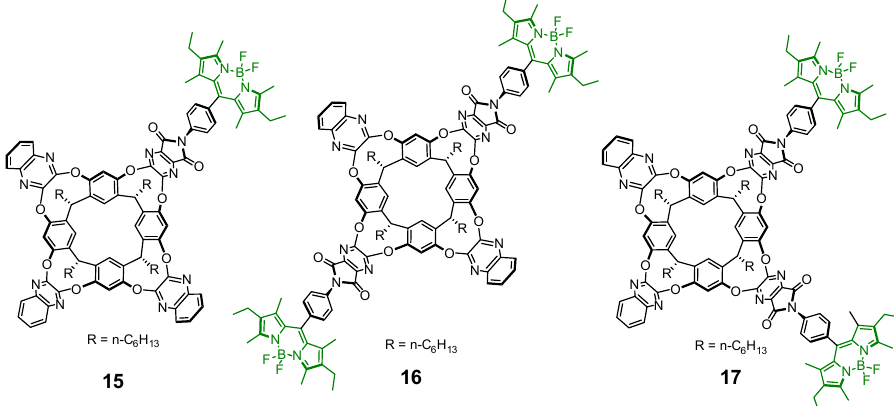
Figure 14. Chemical structures of BODIPY-decorated resorcin[4]arenes 15–17 .